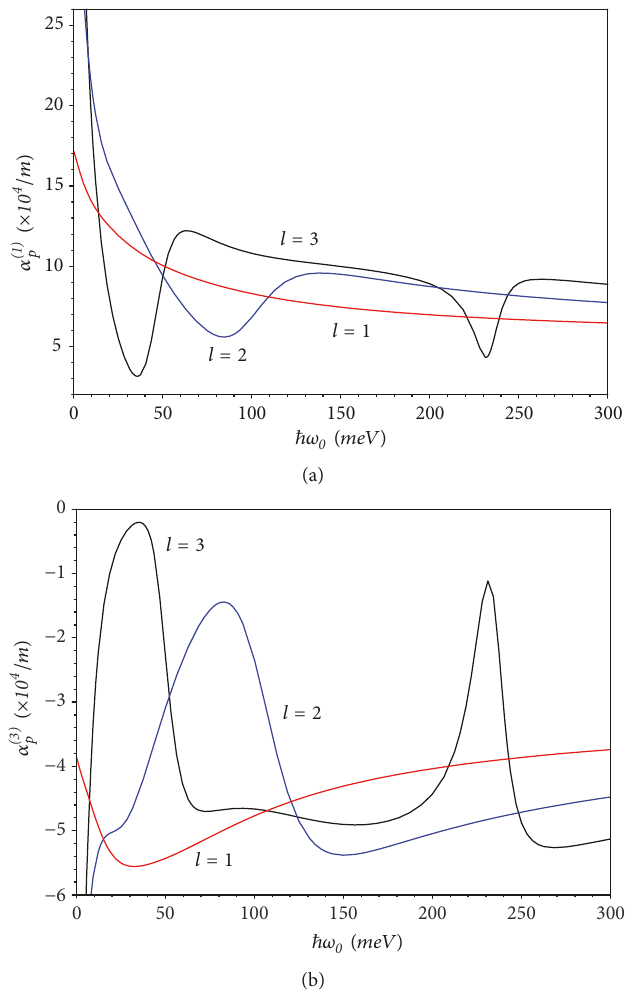
Figure 2: (a) Variation of first-order contribution to AC (at resonance), 𝛼 (1) 𝑝 , with the inverse parabolic potential for a CQW of radius 𝑅 = 100 ˚A. The three curves have been generated for the first three radial quantum numbers (𝑙 = 1,2 and 3) , for the 𝑚 = 0 󳨀→ |𝑚| = 1 transition. (b) Same as for (a), but for the third-order contribution of AC, 𝛼 (3) 𝑝